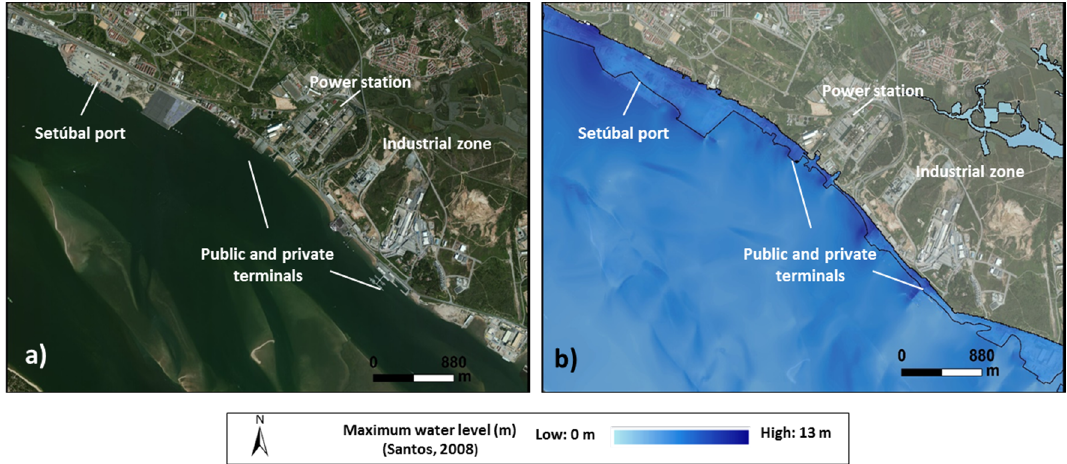
Figure 6. Industrial zone of Setúbal study area: ( a ) Satellite image from study area; ( b ) Tsunami inundation from numerical model results for the industrial zone of Setúbal